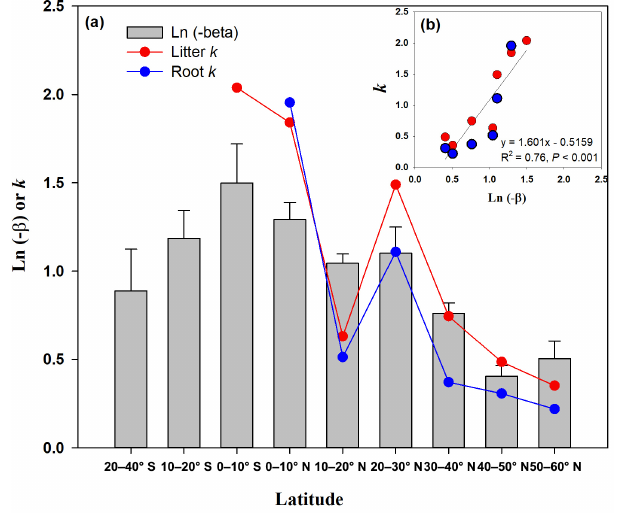
Figure 4. Variation of mean ln ( − β) value across latitude (bar chart), litter decomposition rate k (yr − 1 , red dots; Zhang et al., 2008) and root decomposition rate k (yr − 1 , blue dots; Silver and Miya, 2001) at the global scale. The inner panel is the regression between soil ln ( − β) value and litter and root decomposition rate k